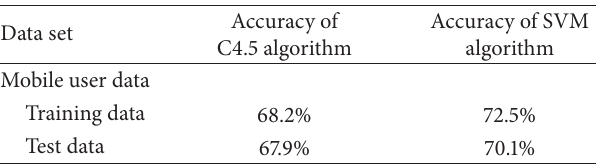
Table 4: Compare C4.5 to decision tree based on genetic algorithm on accuracy.